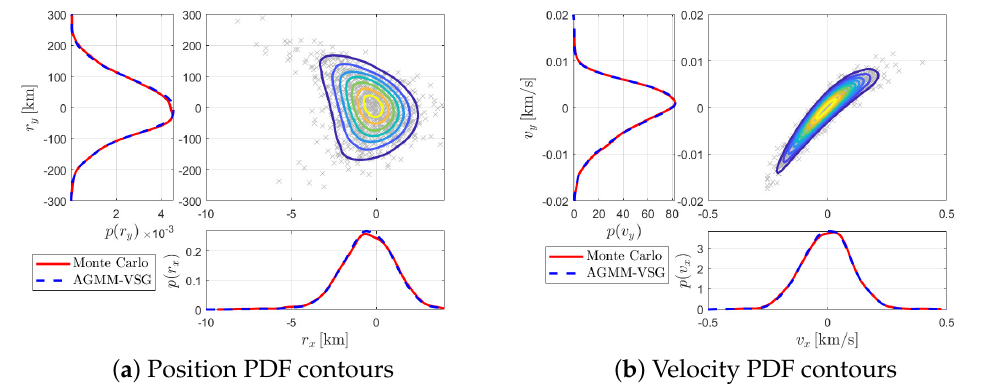
Figure 6. PDF contours using AGMM-VSG with Monte Carlo samples of LEO case.